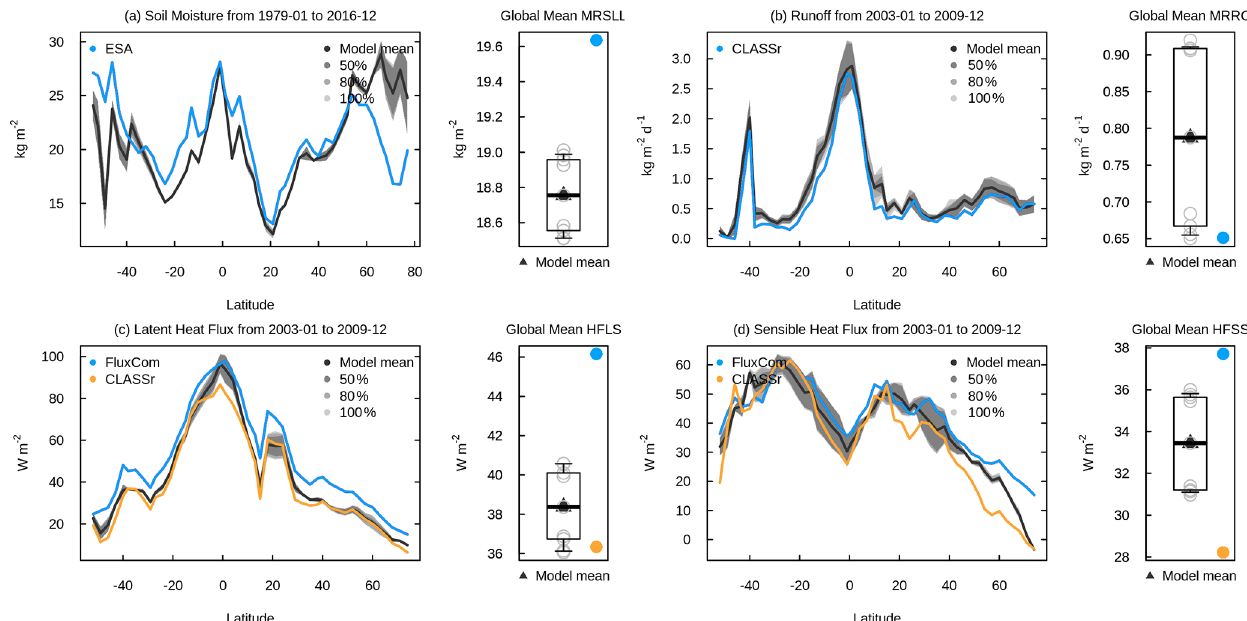
Figure A12. Zonally averaged values of soil moisture (a) , runoff (b) , latent heat flux (c) , and sensible heat flux (d) from the eight simulations summarized in Table 1. The model results are shown as their mean (black) and the spread across the eight simulations indicated by 50%, 80%, and 100% ranges in different shades of grey. The observation-based estimates used in AMBER to calculate scores are shown in coloured